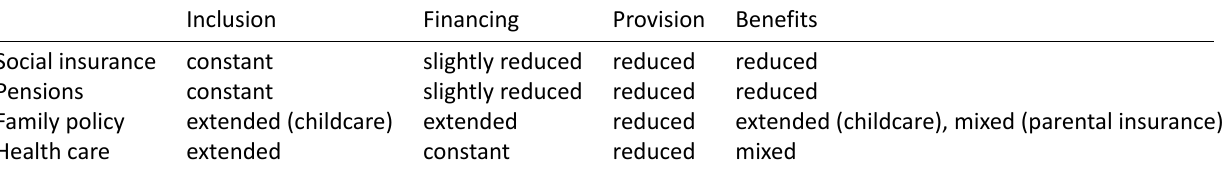
Table 1. Changes in dimensions of universalism in Swedish welfare